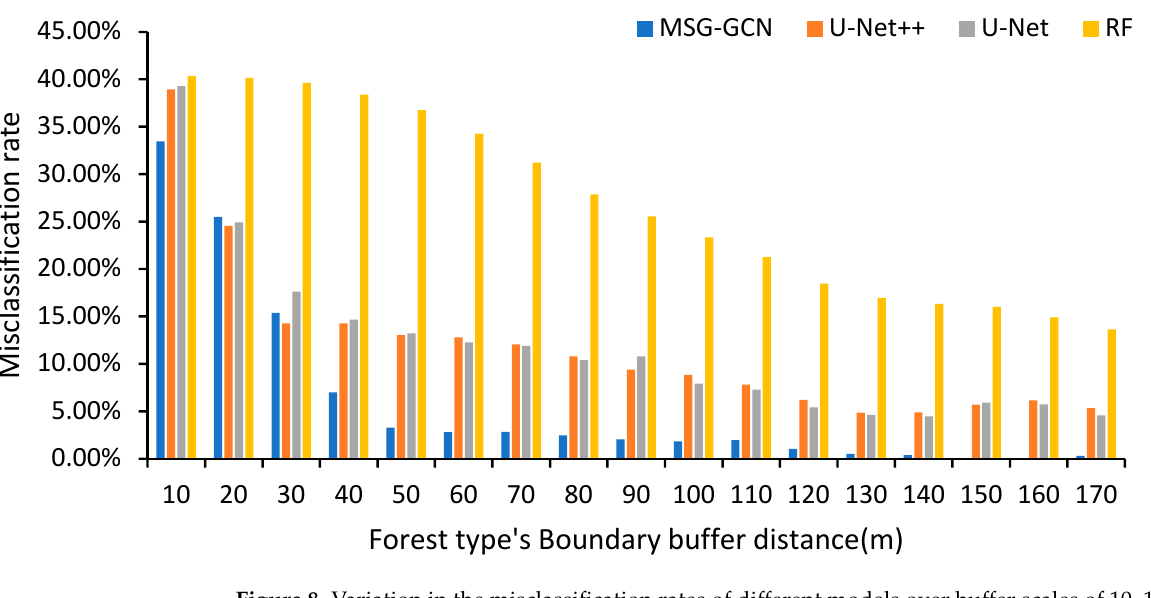
Figure 8. Variation in the misclassification rates of different models over buffer scales of 10–170 m.